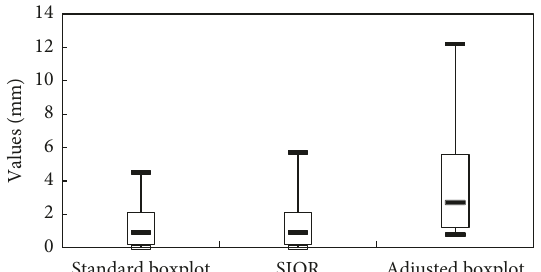
Figure 6: Boxplots of the three methods for Wuyigong